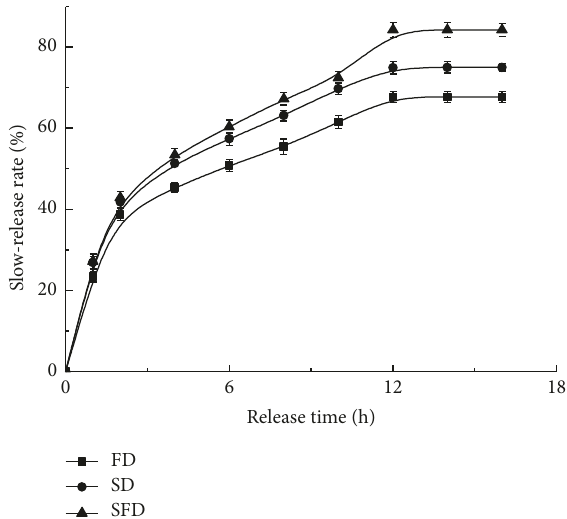
Figure 4: The relationship between the storage time and propanal content of fish oil microcapsules by different drying